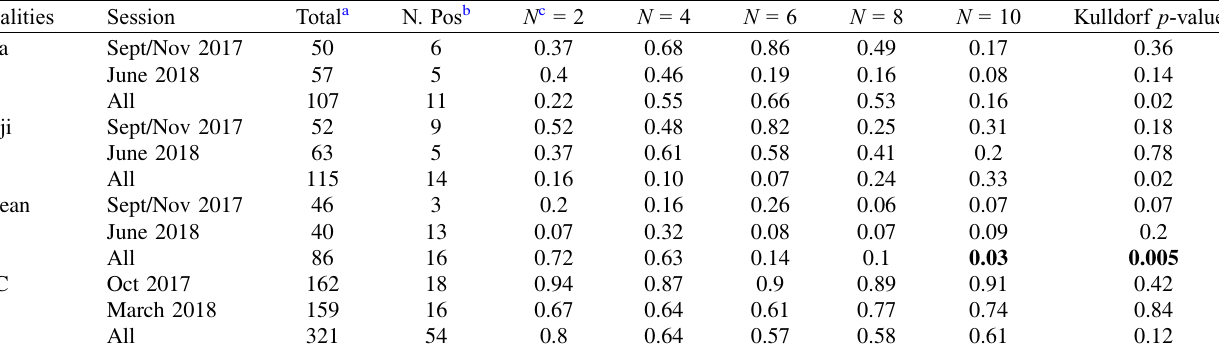
Table 3. Monte Carlo p -values (10,000 simulations) to investigate signi fi cant clustering of T. gondii -infected small mammals within each study area based on the Cuzick – Edwards test. Localities